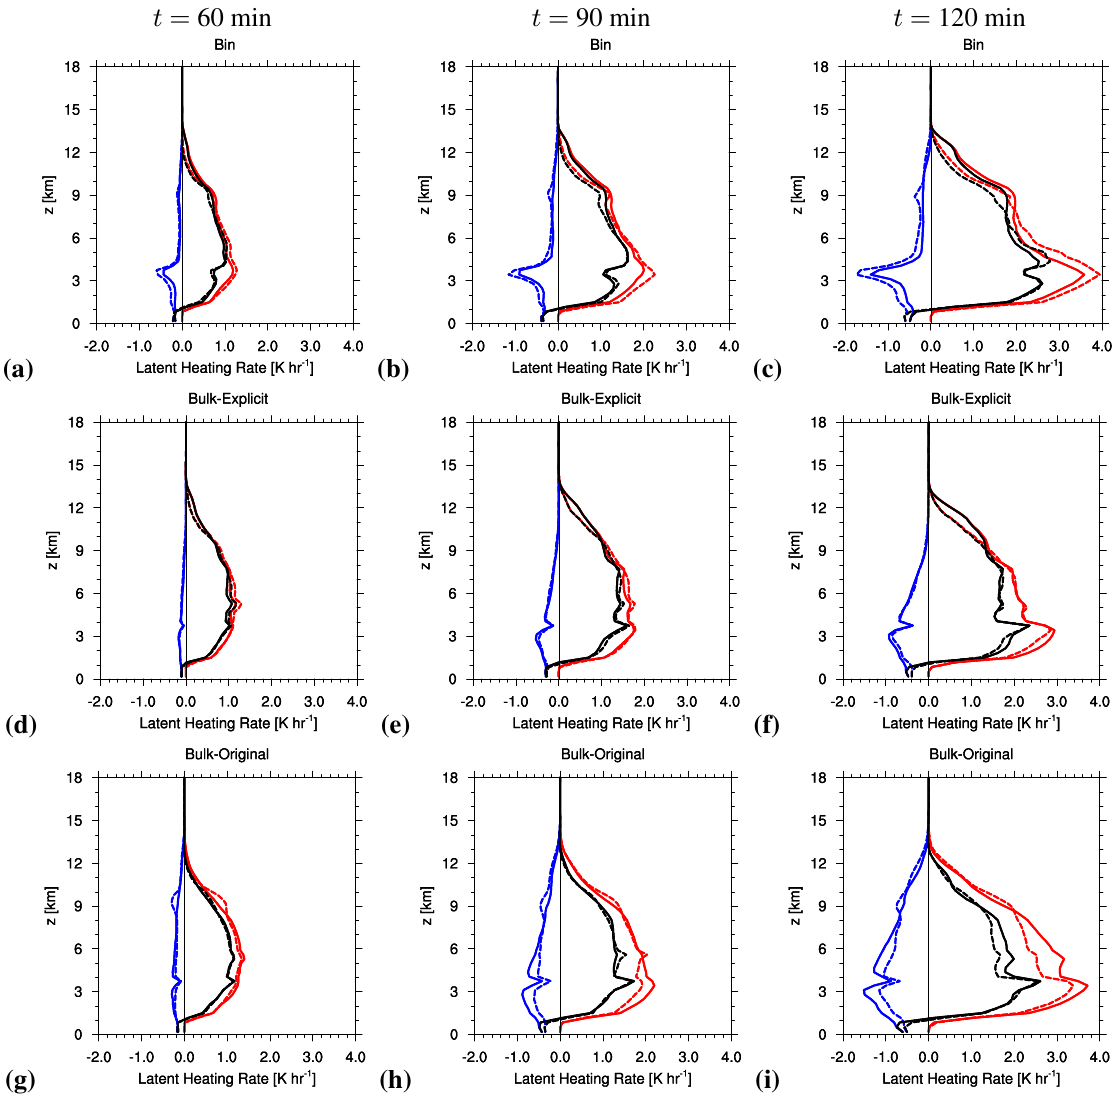
Fig. 9. Simulated latent heating rates for the bin (a–c) , bulk-explicit (d–f) , bulk-original (g–i) model configurations at 60min (a, d, g) , 90min (b, e, h) , and 120min (c, f, i) . The net heating rate (black) is decomposed into the heating (red) caused by condensation, deposition, freezing, and riming and cooling (blue) caused by evaporation, sublimation, and melting. Results are shown for the “Clean” (solid) and “Polluted” (dashed) aerosol scenarios and baseline initial conditions.